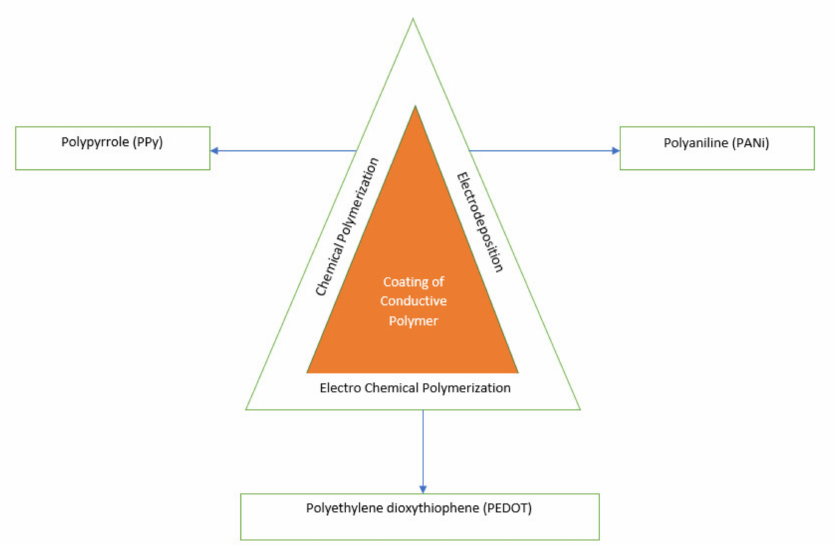
Figure 4. The different coating methods of the